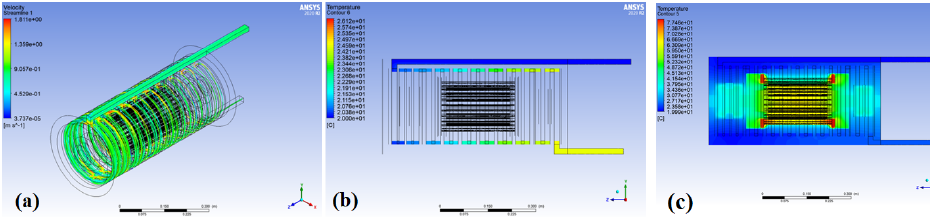
Figure 11. ( a ) Velocity, ( b ) temperature distributions of water-cooling flow and ( c ) temperature distribution of overall PMSM spindle.